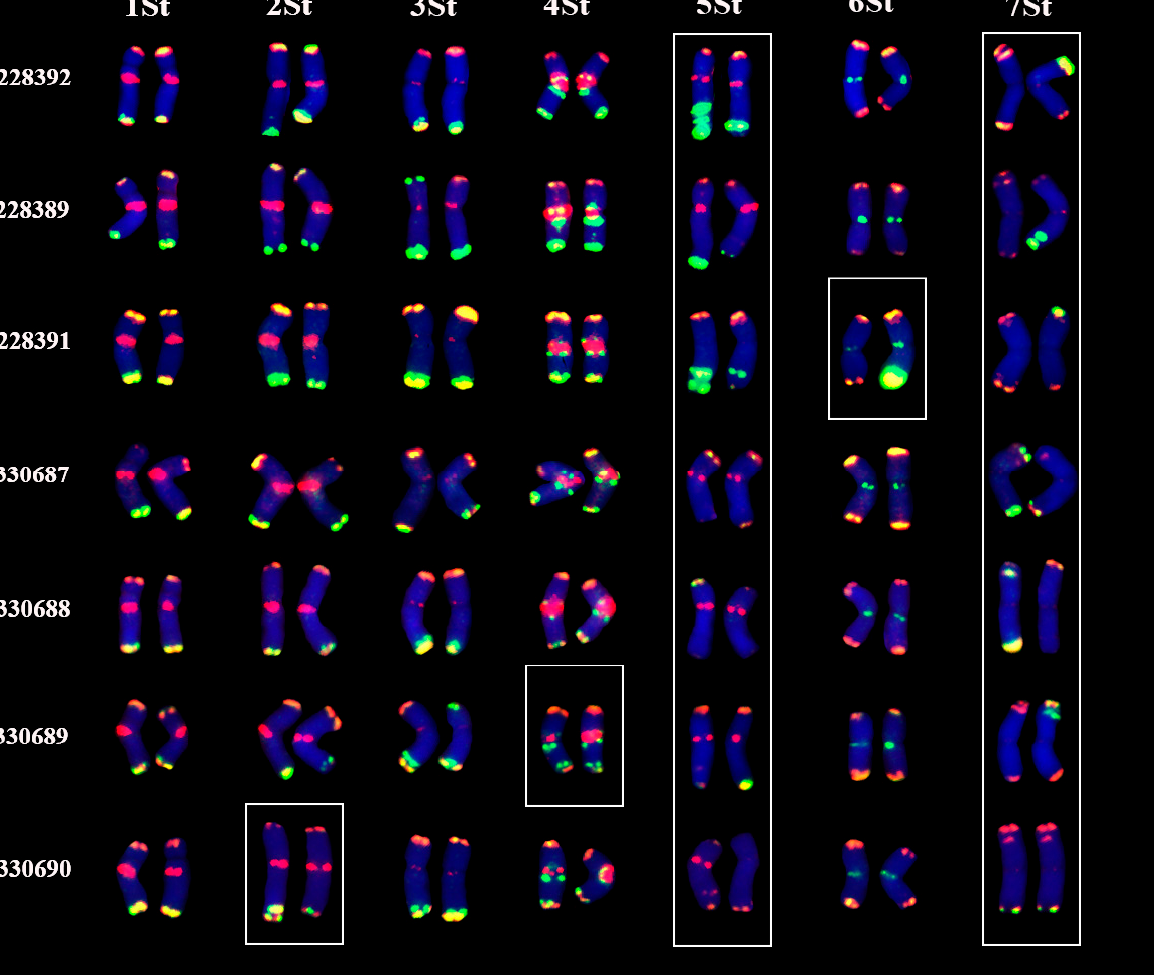
Figure 6. Chromosome polymorphism of seven P. libanotica accessions. The patterns of each chro- mosome pair were characterized by STlib_96 + Stlib_98 (green) and STlib_117 (red). The white box presents chromosome pairs with different signals.